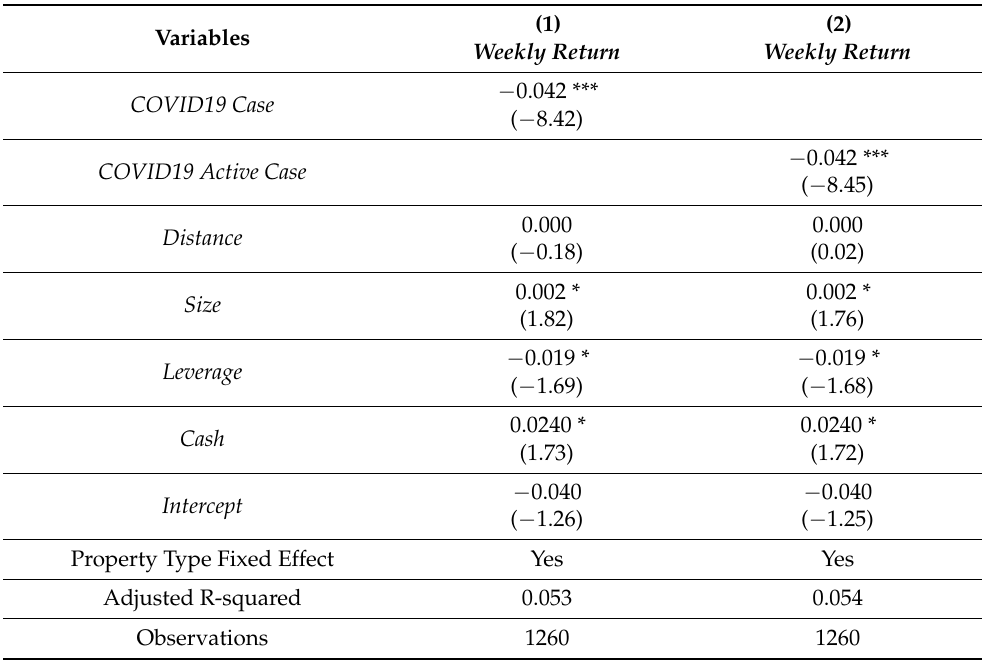
Table 2. Stock market returns during the COVID-19